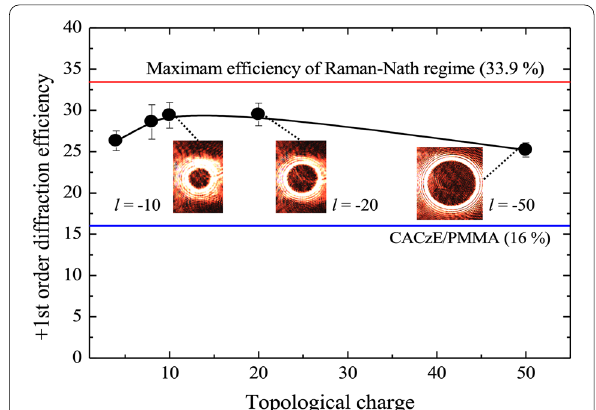
Fig. 9 The plot of diffraction efficiency with different topological charge of the optical vortex beam. Diffraction efficiency close to the theoretical maximum for Raman-Nath regime (red line) has been